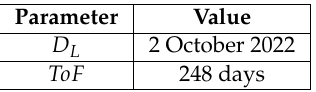
Figure 14. The designed heliocentric cruise solution showing the selected interplanetary trajectory between Earth and Mars. Table 5. Design variables of the optimal heliocentric cruise design problem.